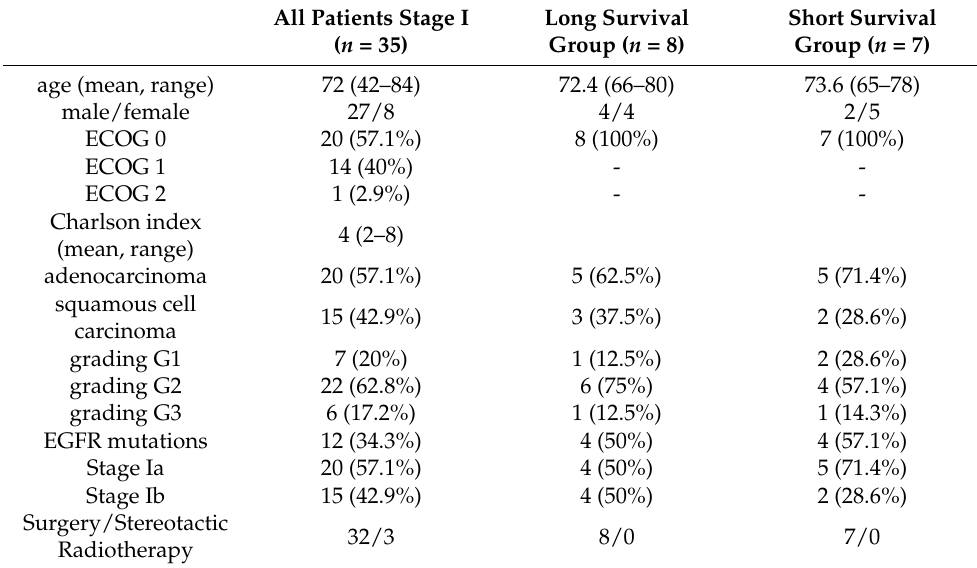
Table 1. Descriptive features of patients.